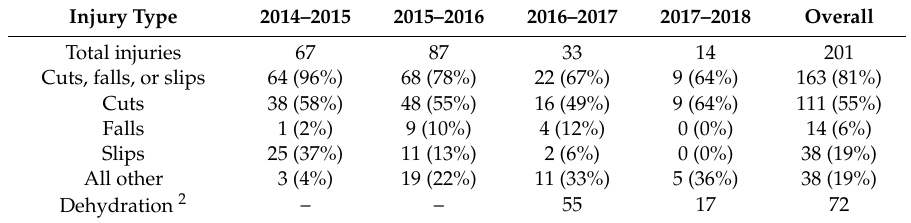
Table 1. Summary 1 of recorded occupational injuries among sugarcane harvesters in Southwestern